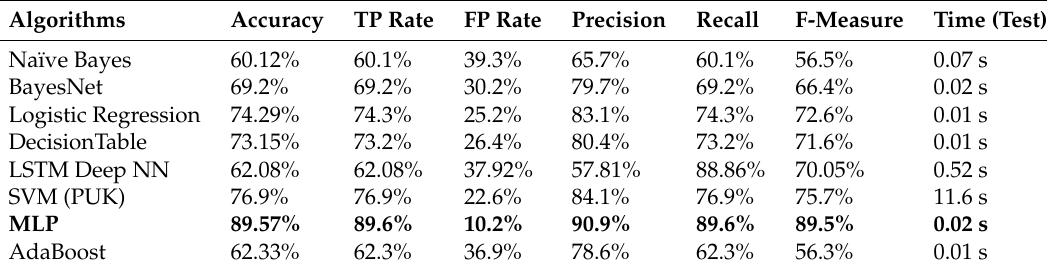
Table 10. Performance evaluation for attack scenario 7.